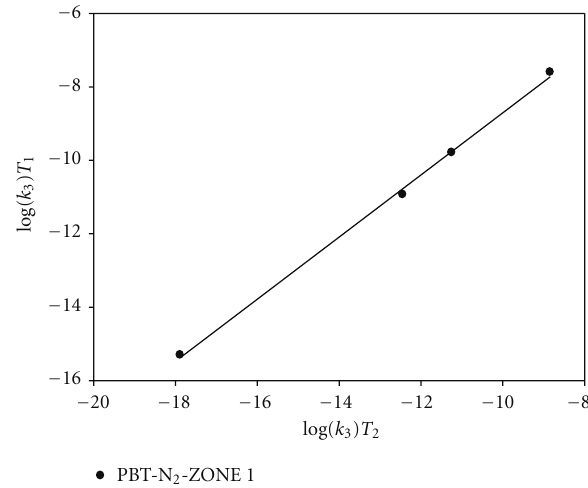
Figure 11: Plot of log k 3 versus log k 3 for PBT in N 2 atmosphere 660 680 (zone 1).